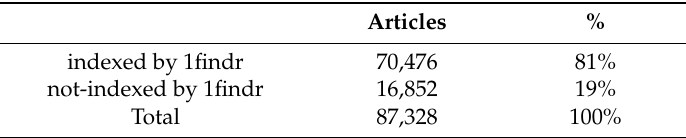
Table 5. Number of articles indexed by 1findr, 2011–2016.